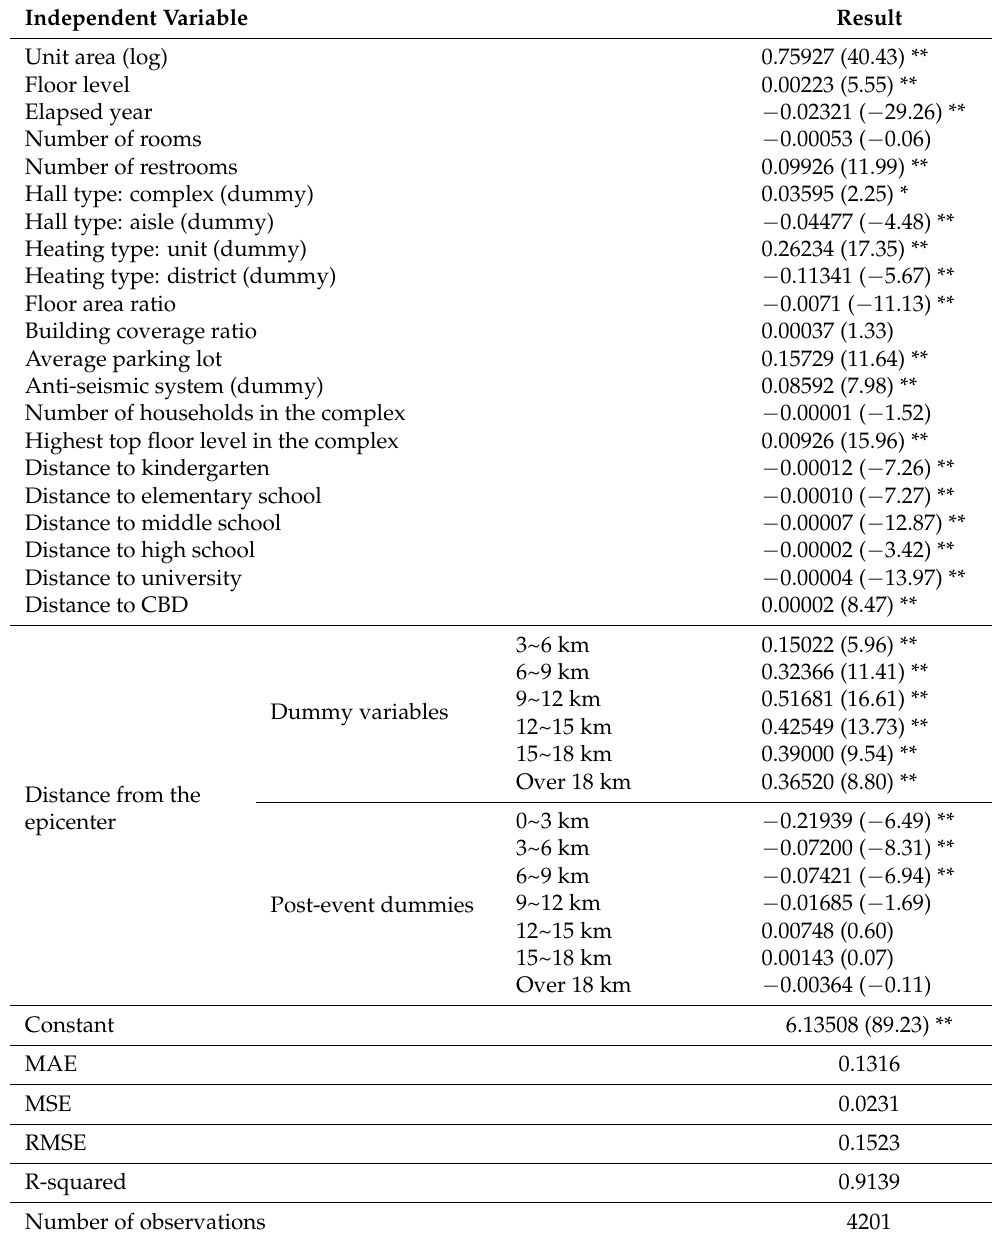
Table 5. Regression